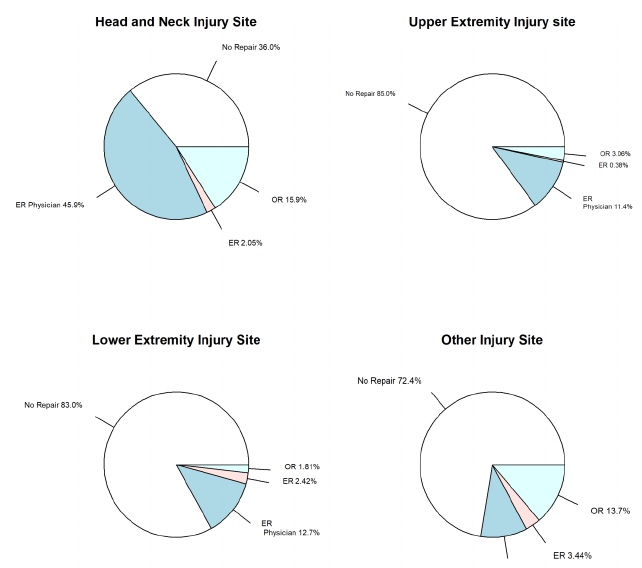
Figure 2. Level of intervention by anatomic site of